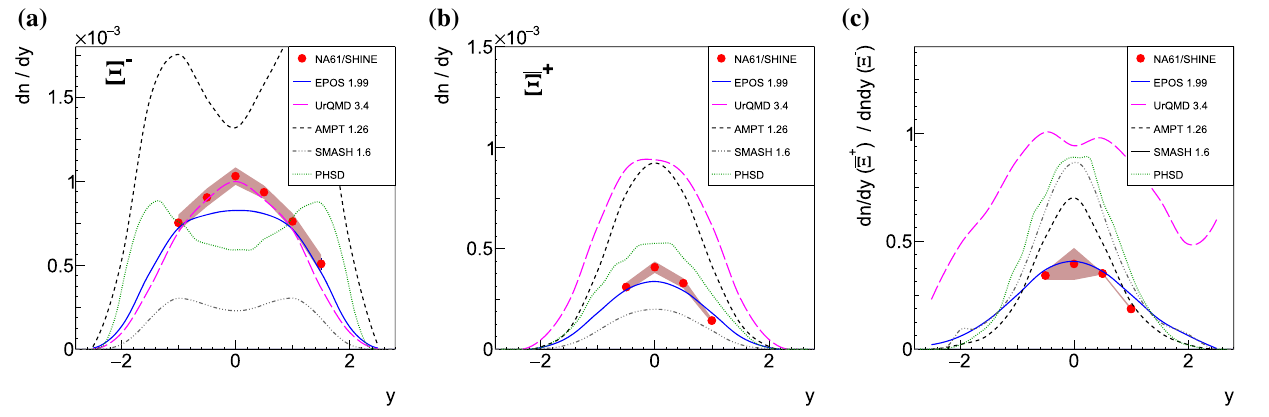
Epos 1.99 [33], Ampt 1.26 [36–38], Smash 1.6 [39–41] and Phsd [42, 43] predictions are shown as magenta, blue, black, gray and green lines, respectively